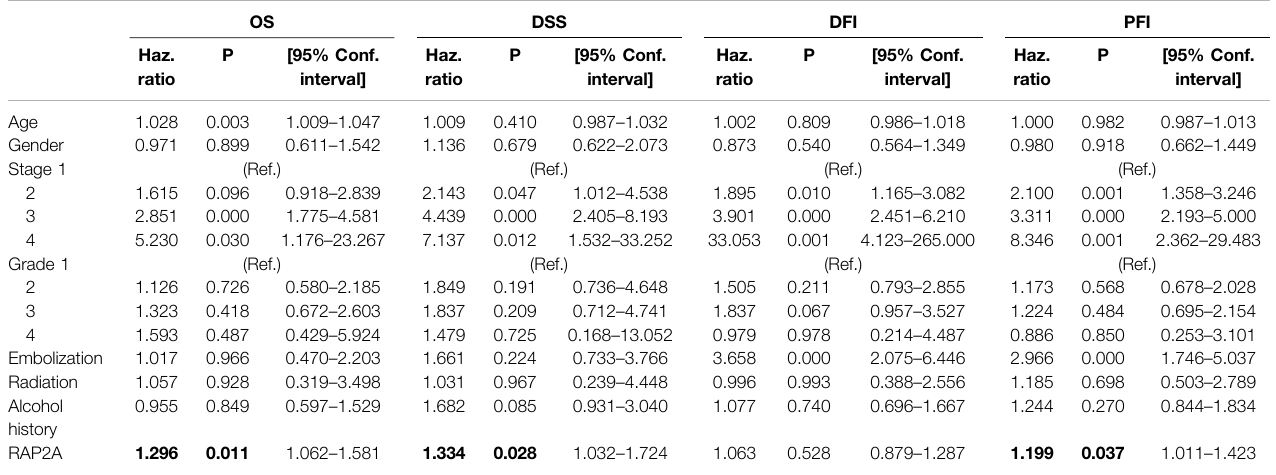
TABLE 3 | Multivariate analysis for association of RAP2A expression with patient prognosis in